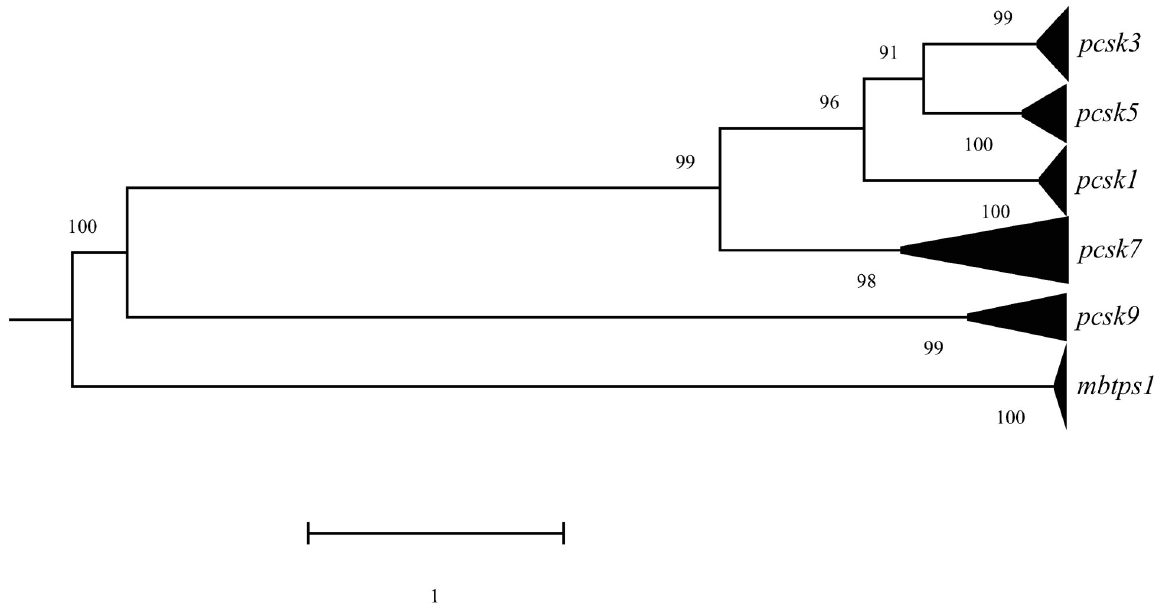
Fig 6. Phylogenetic analysis of six PCSKs. The analysis involves the codon sequences of each PCSK’s members from 14 species. Each branch is marked by its PCSK name on the right side. Branch length scale represents 1 substitution per site. The number written at each node represents the bootstrap value indicating the phylogenetic confidence of the tree